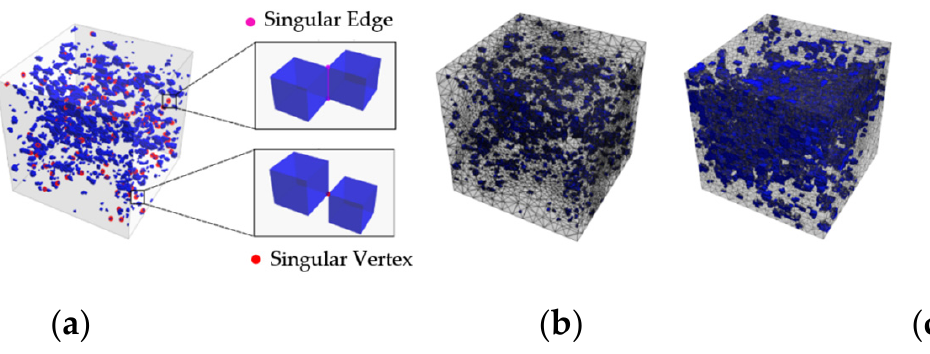
Figure 7. Finite element discretization: singularities inside the microstructure geometry scanned ( a ); two different high-strength concrete meshes ( b , c ).